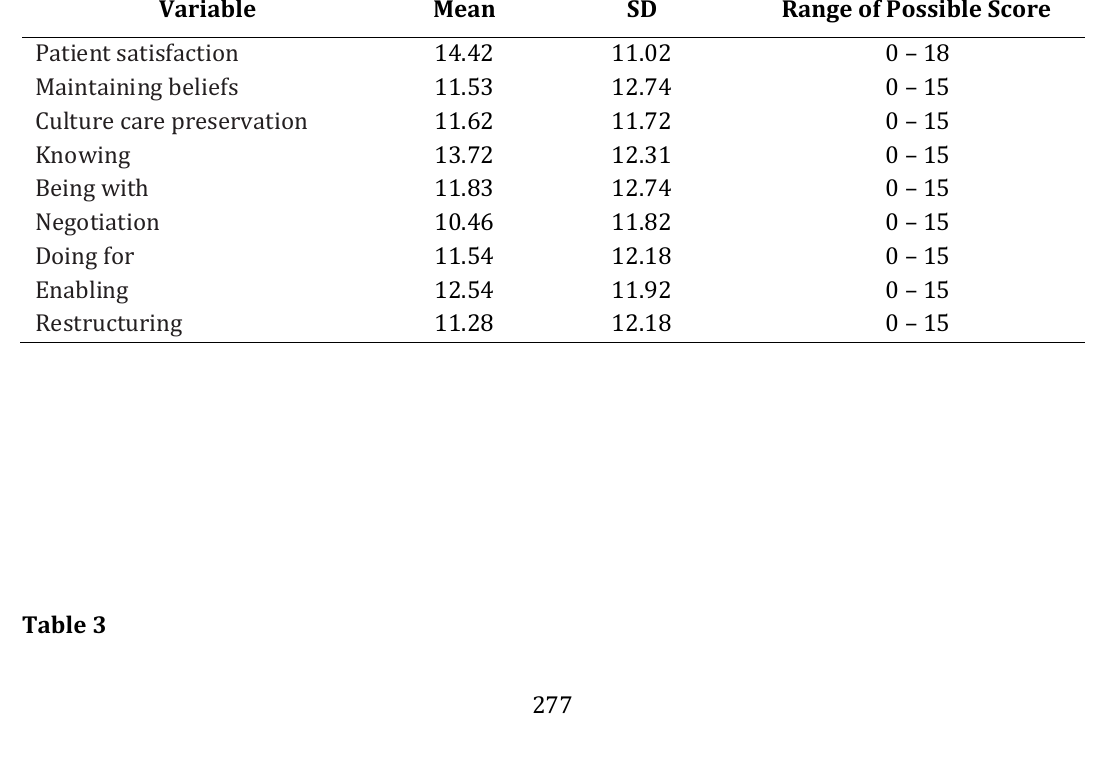
Distribution of the Mean Value of All Variables Variable Range of Possible Score Patient satisfaction Maintaining beliefs